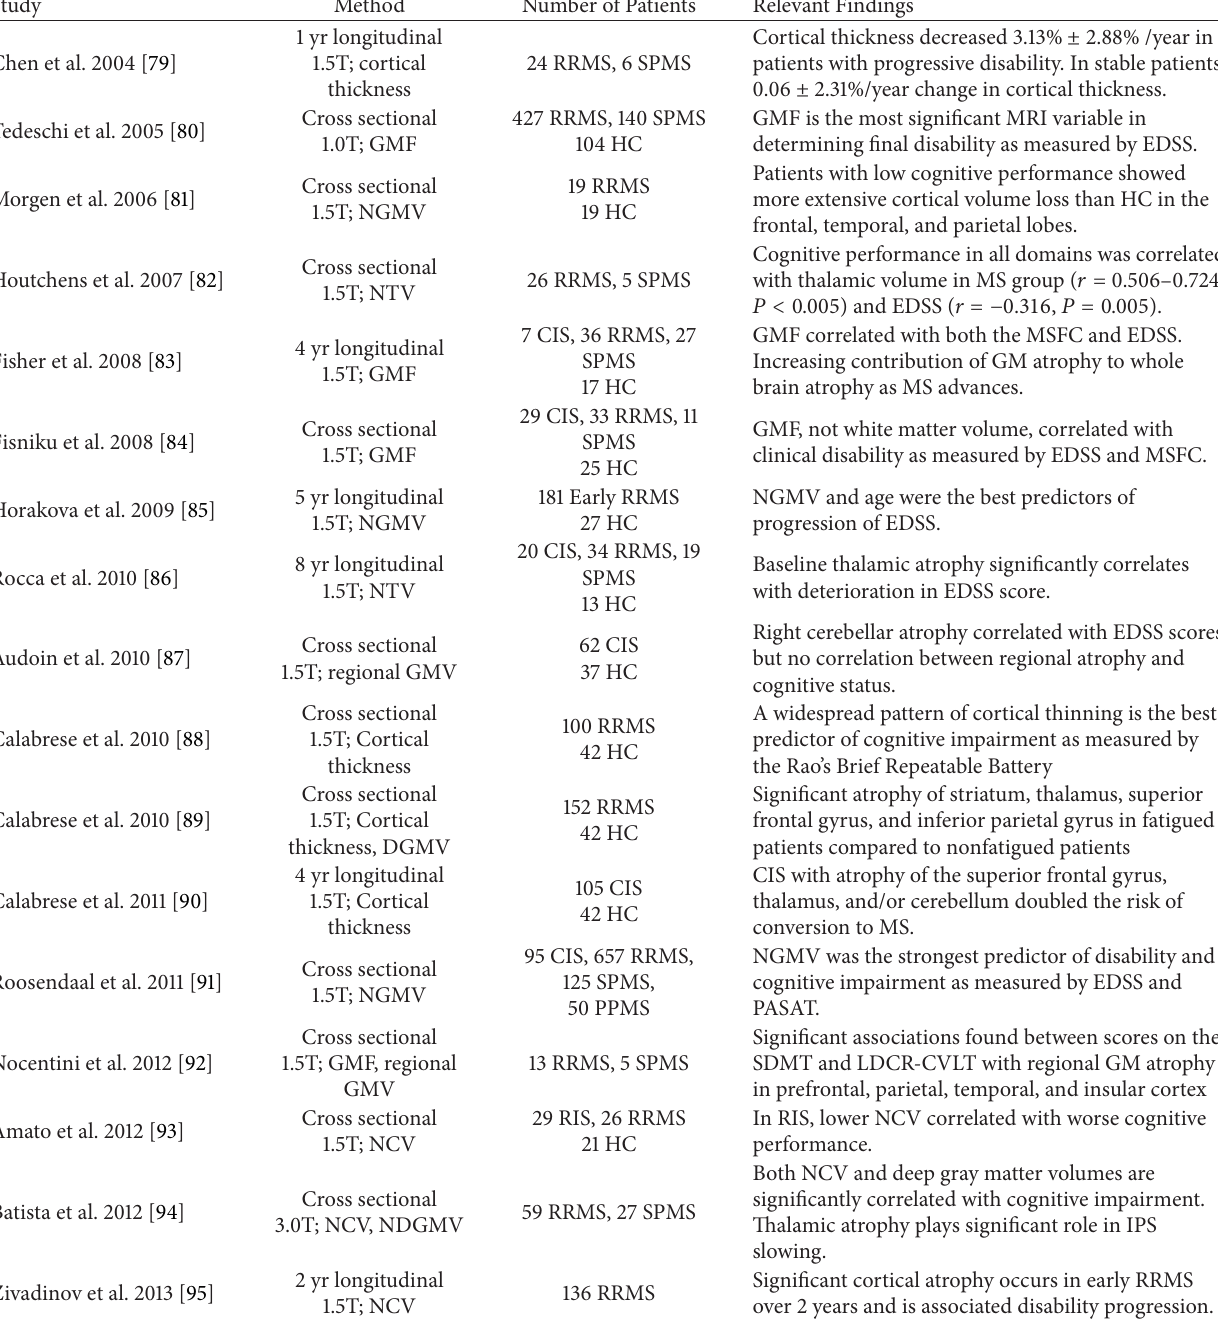
Table 3: Neuroimaging studies evaluating the relationship between gray matter atrophy, clinical disability, and cognitive